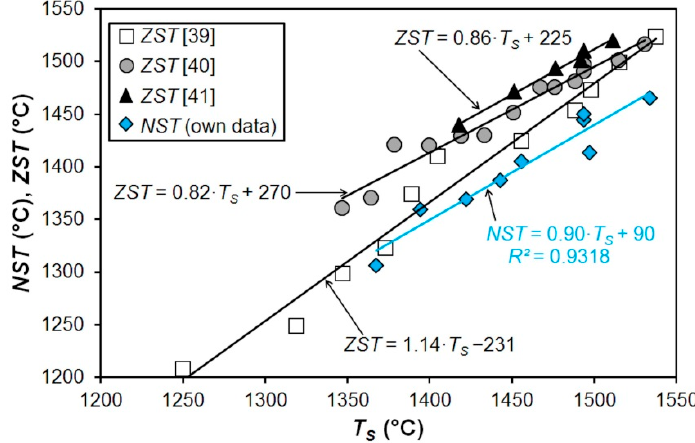
Figure 7. Zero strength temperature and measured nil-strength temperature values depending on the equilibrium solidus temperature.